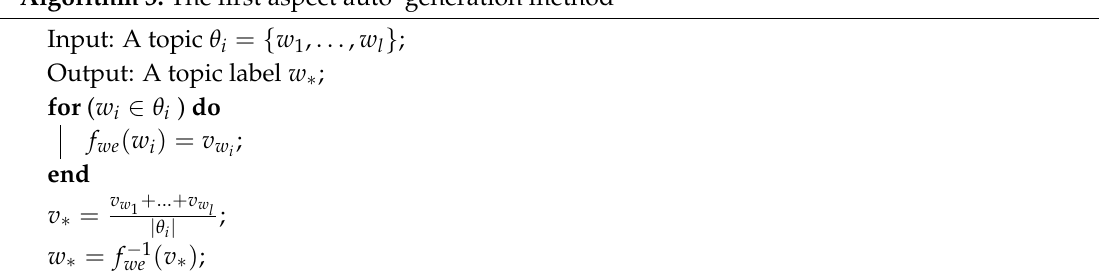
Algorithm 3: The first aspect auto–generation